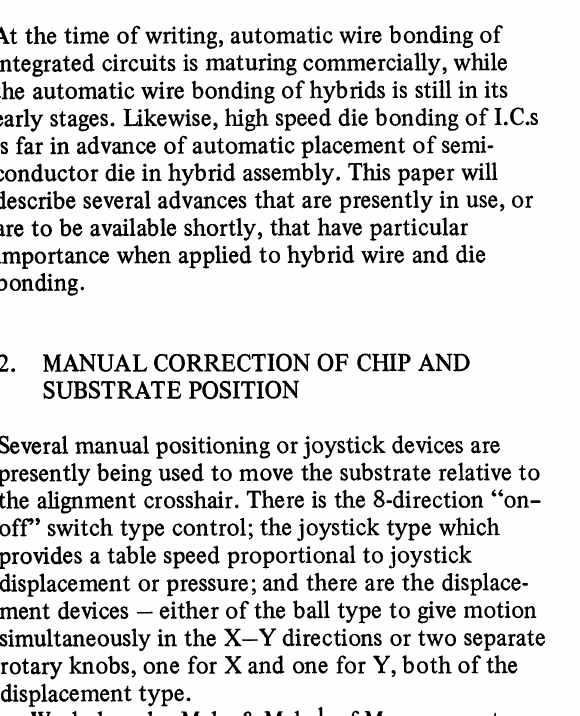
separate XY displacement type control knobs, if the resistance to rotation is kept low. Apparently, the